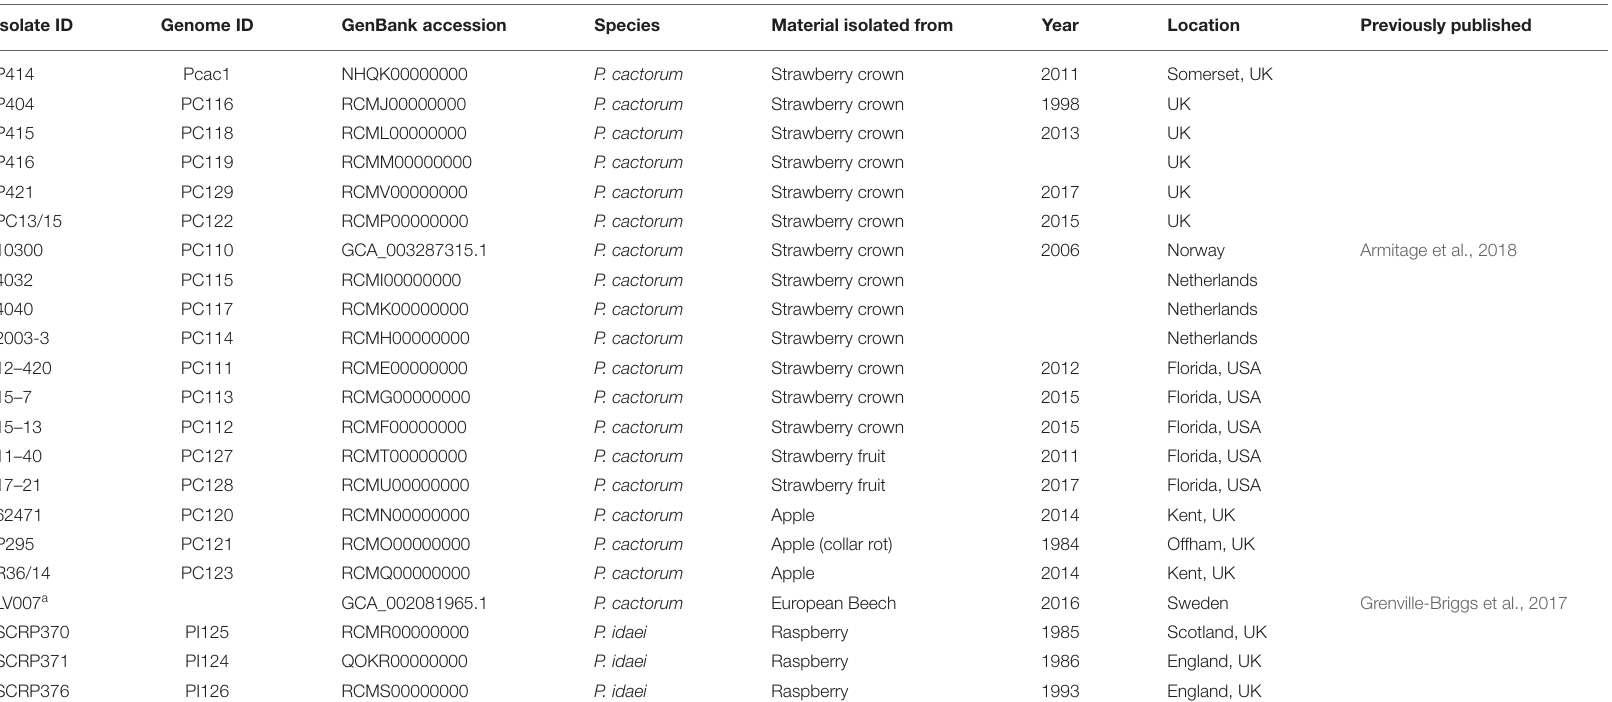
TABLE 1 | Summary of Phytophthora cactorum and Phytophthora idaei isolates used in this